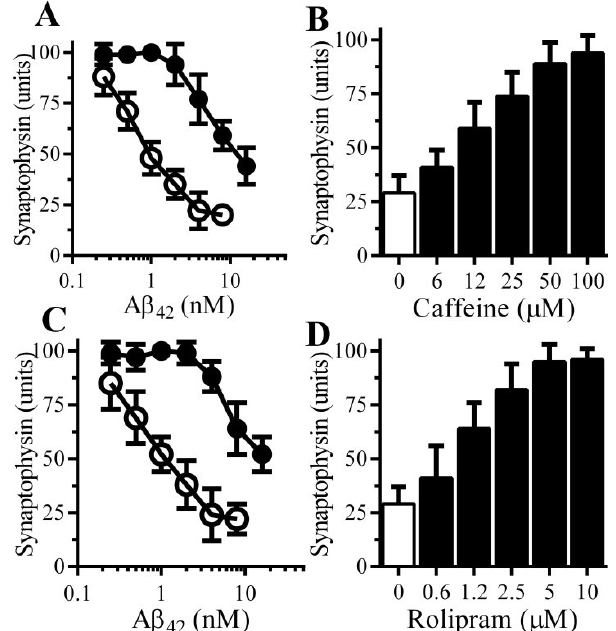
Figure 3. Caffeine and Rolipram protect neurons against Aβ-induced synapse damage: ( A ) The amounts of synaptophysin in neurons pre-treated with control medium (○) or 100 µM caffeine (●) and incubated with Aβ 42 as shown. Values are means ± SD from triplicate experiments performed 4 times ( n = 12); ( B ) The amounts of synaptophysin in neurons pre-treated with control medium (□) or caffeine as shown (■) and incubated with 2 nM Aβ 42 . Values are means ± SD from triplicate experiments performed 3 times ( n = 9); ( C ) The amounts of synaptophysin in neurons pre-treated with control medium (○) or 10 μM rolipram (●) and incubated with Aβ 42 as shown. Values are means ± SD from triplicate experiments performed 4 times ( n = 12); ( D ) The amounts of synaptophysin in neurons pre-treated with control medium (□) or rolipram as shown (■) and incubated with 2 nM Aβ 42 . Values are means ± SD from triplicate experiments performed 3 times ( n =